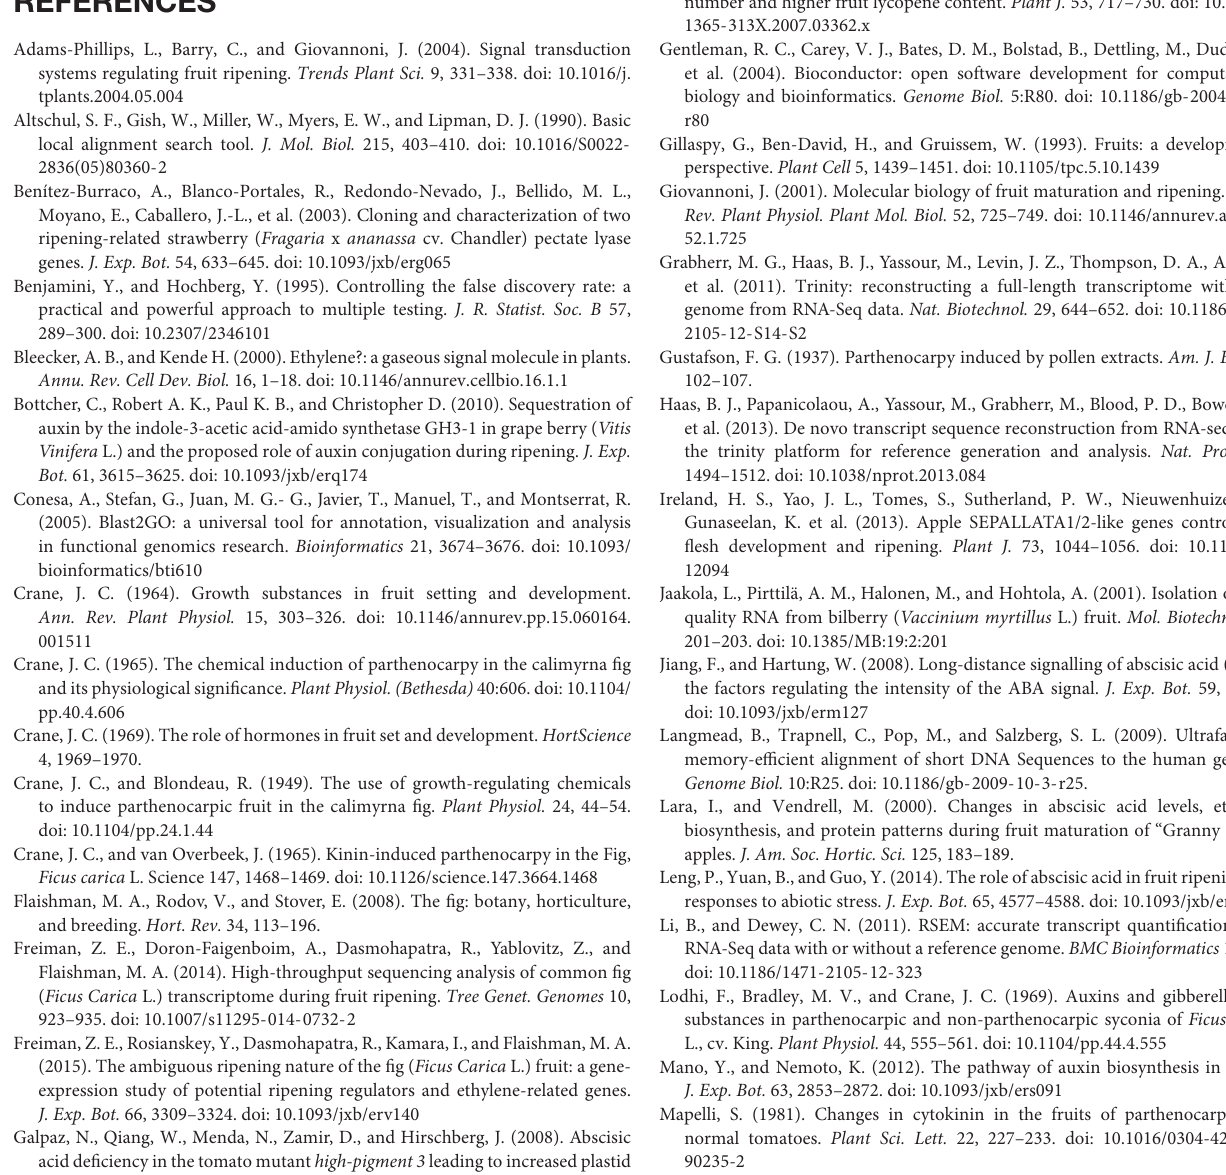
FIGURE S4 | Heat map of the log2-normalized transcriptomic representation profiles of 13 ABA metabolism-related gene transcripts in parthenocarpic and pollinated fruit inflorescence and pulp. Red,